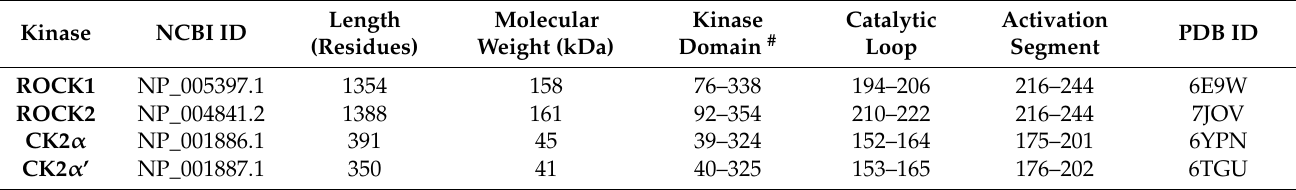
Figure 3. Measurement of in vitro inhibitory efficacy of KD025 against CK2. CK2 activity assay based on the ELISA system was performed using KD025 as an inhibitor. ( A ) Enzymatic activity was measured at the eight-point concentration (0, 0.1, 1, 3, 10, 30, 100, and 1000 nM for KD025; 0, 0.001, 0.01, 0.03, 0.1, 0.3, 1, and 10 nM for CX-4945) of drugs. IC 50 was calculated by constructing a dose-response curve using the nonlinear least-square fit model. CX-4945 was used as a positive control. The experiment was performed in duplicate. ( B ) Inhibitory effects of KD025 were compared with pan-ROCK inhibitor fasudil. Higher concentration (150 nM) than experimentally determined IC 50 of KD025 was applied for KD025 and fasudil. Potent CX-4945 was tested at 1.5 nM. The assay was performed in singlet. Table 1. Characters of ROCKs and CK2 proteins used in structure comparison.